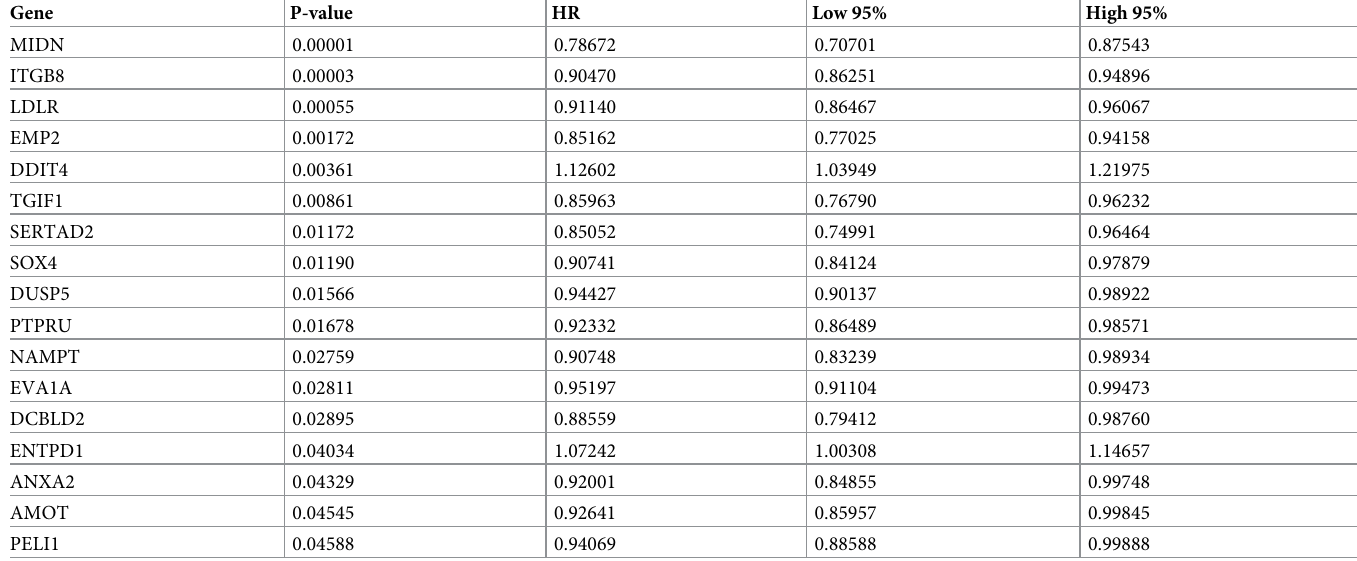
Table 1. Result of univariate survival